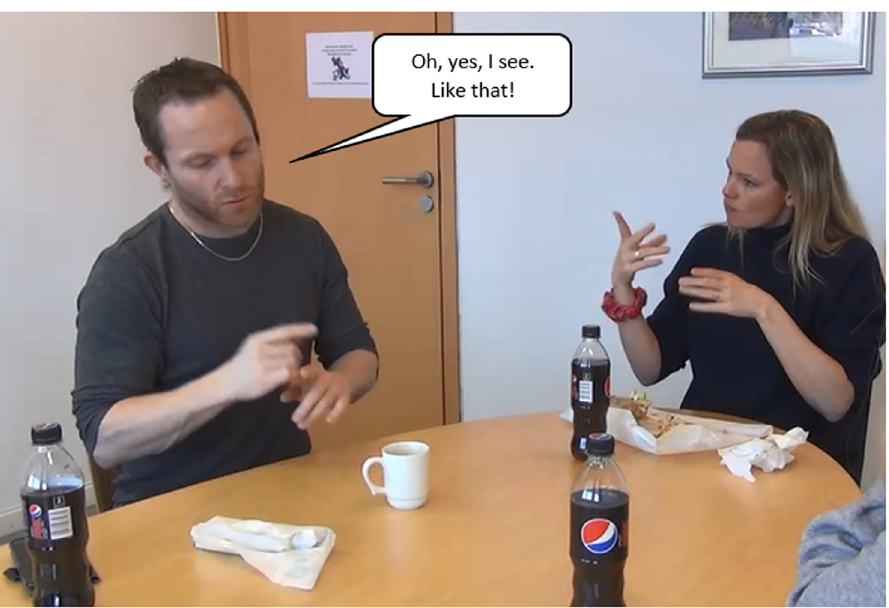
Figure 4: Display of understanding ( left ) . ( End of line 10.